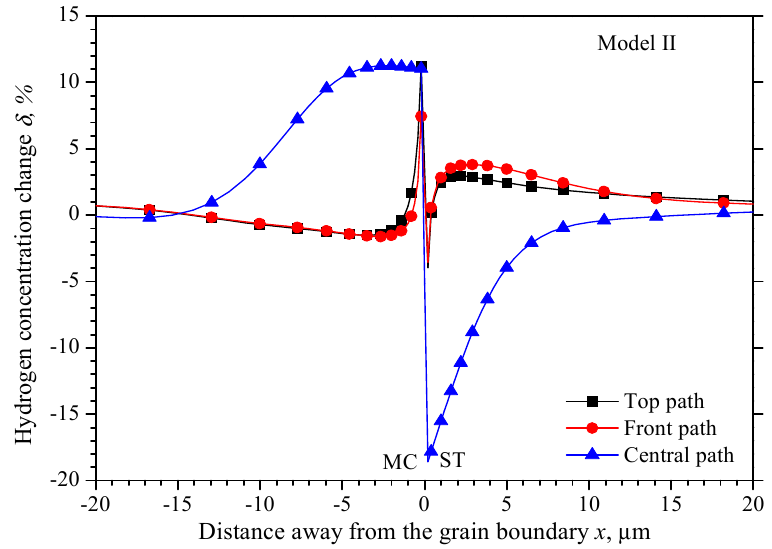
Figure 8. The hydrogen concentration distribution in model II bicrystal.